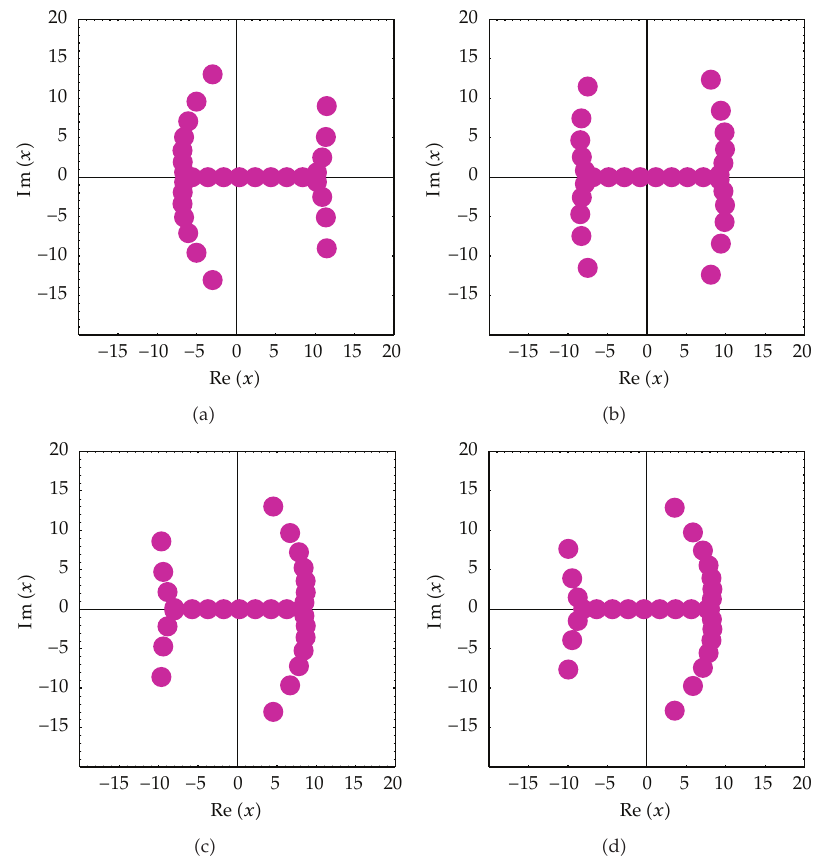
Figure 2: Zeros of E n,q,w (cid:2) x : a (cid:3) for q (cid:6) 1 / 10 , 3 / 10 , 7 / 10 , 9 / 10.